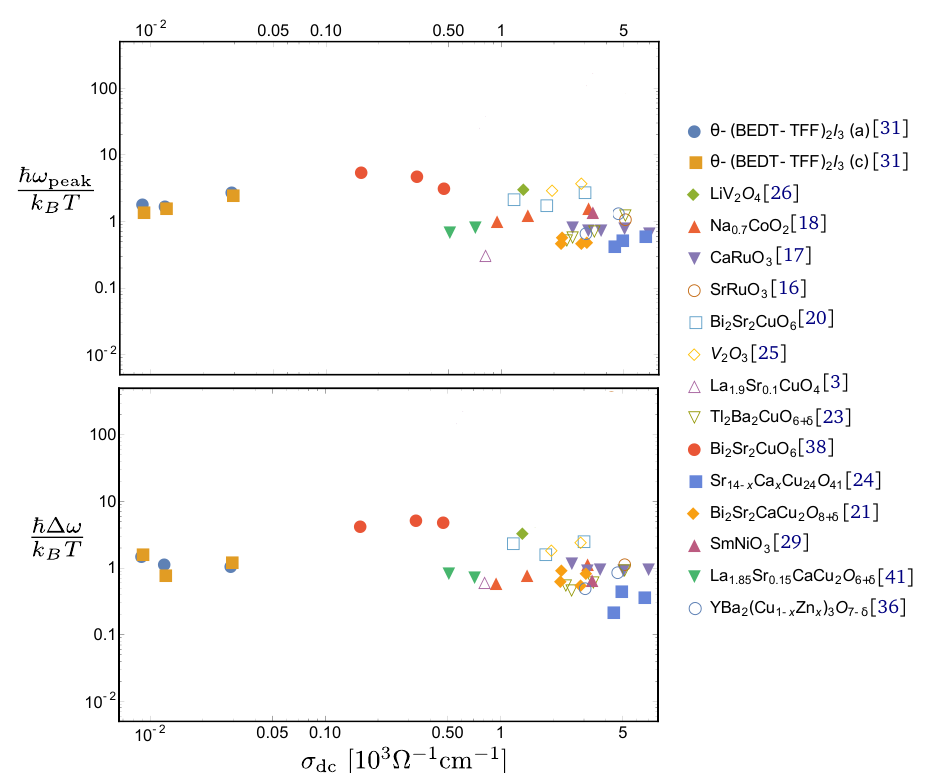
Figure 2: Location and width of the peak in σ ( ω ) versus dc conductivity bad